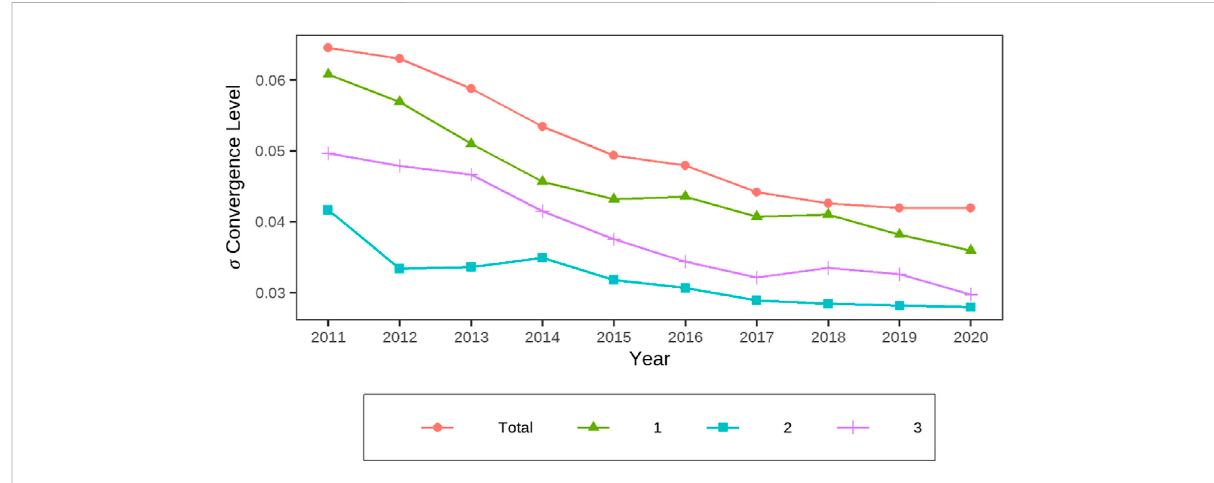
FIGURE 6 Levels of σ convergence in the three major urban agglomerations in the Yangtze River Economic Belt.